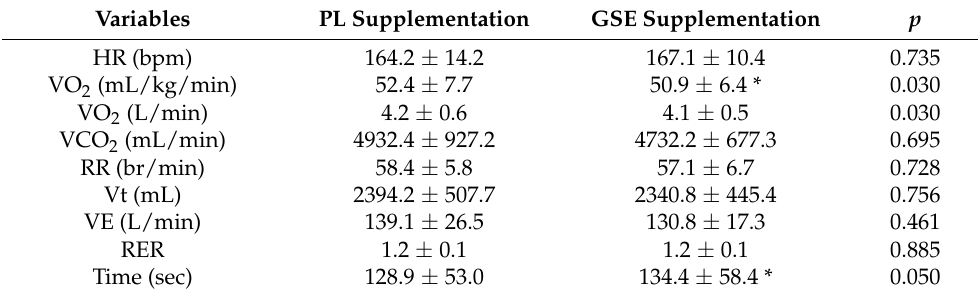
Table 5. Cardiorespiratory responses during the submaximal exercise of 120% of VO 2peak after PL and GSE